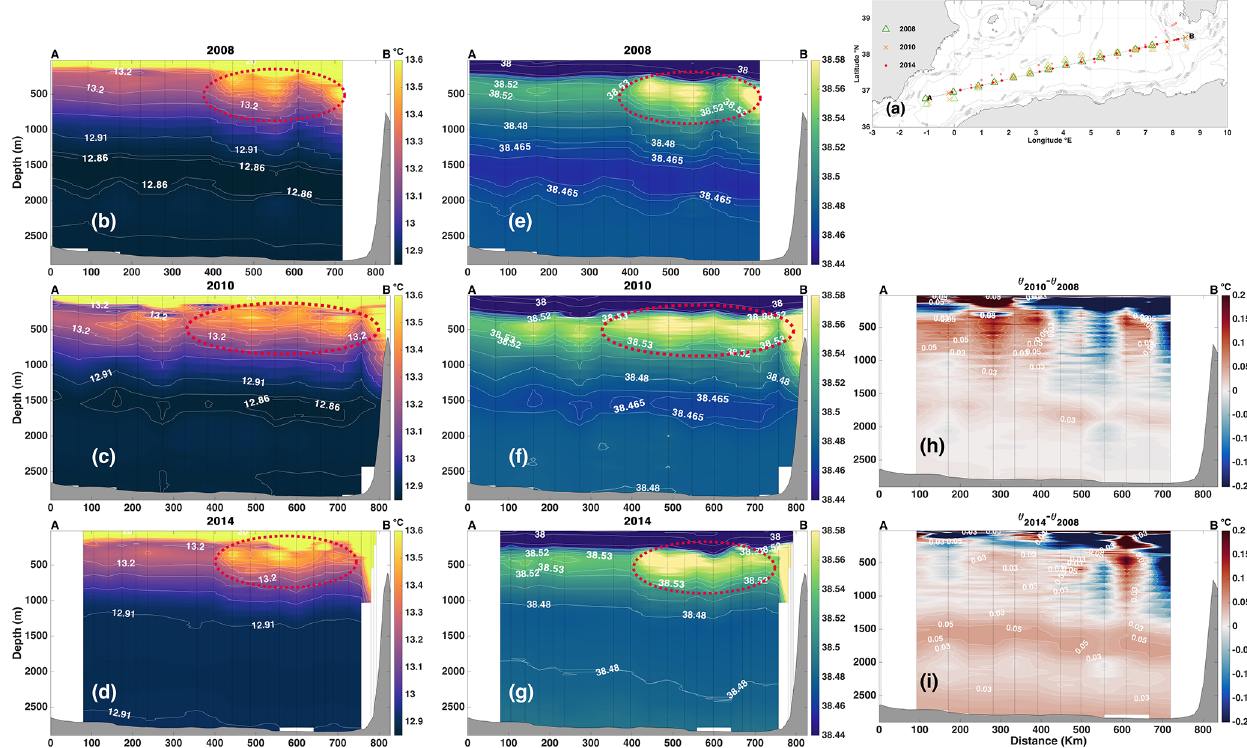
Figure 3. (a) Map of the locations of the CTD casts carried out during MEDCO08 in 2008 (green triangles, Ribotti and Borghini, 2008; Ribotti et al., 2022), during Venus1 in 2010 (orange crosses, Borghini et al., 2019) and during SOMBA-GE2014 in 2014 (red dots, Mortier et al., 2014). For comparison, all stations were perpendicularly projected on the A–B strait line. The faded colors are the actual locations of the casts; the bright ones represent their projections on A–B. East–west sections of (b–d) potential temperature and (e–g) salinity. Differences in potential temperature section (h,i) : θ 2010 − θ 2008 (h) , θ 2014 − θ 2008 (i) .